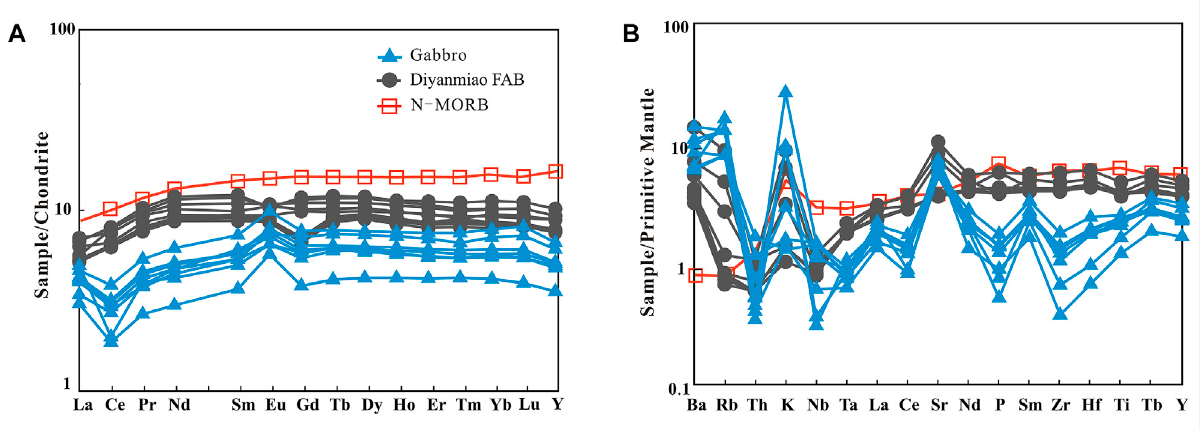
FIGURE 5 (A) Chondrite-normalized REE (Boynton, 1984)and (B) trace element patterns (Sun and McDonough, 1989) for the gabbro and fore-arc basalt (FAB) in the Diyanmiao ophiolite. Data of Diyanmiao FAB is after (Li et al., 2020a). N-MORB values are after Sun and McDonough,